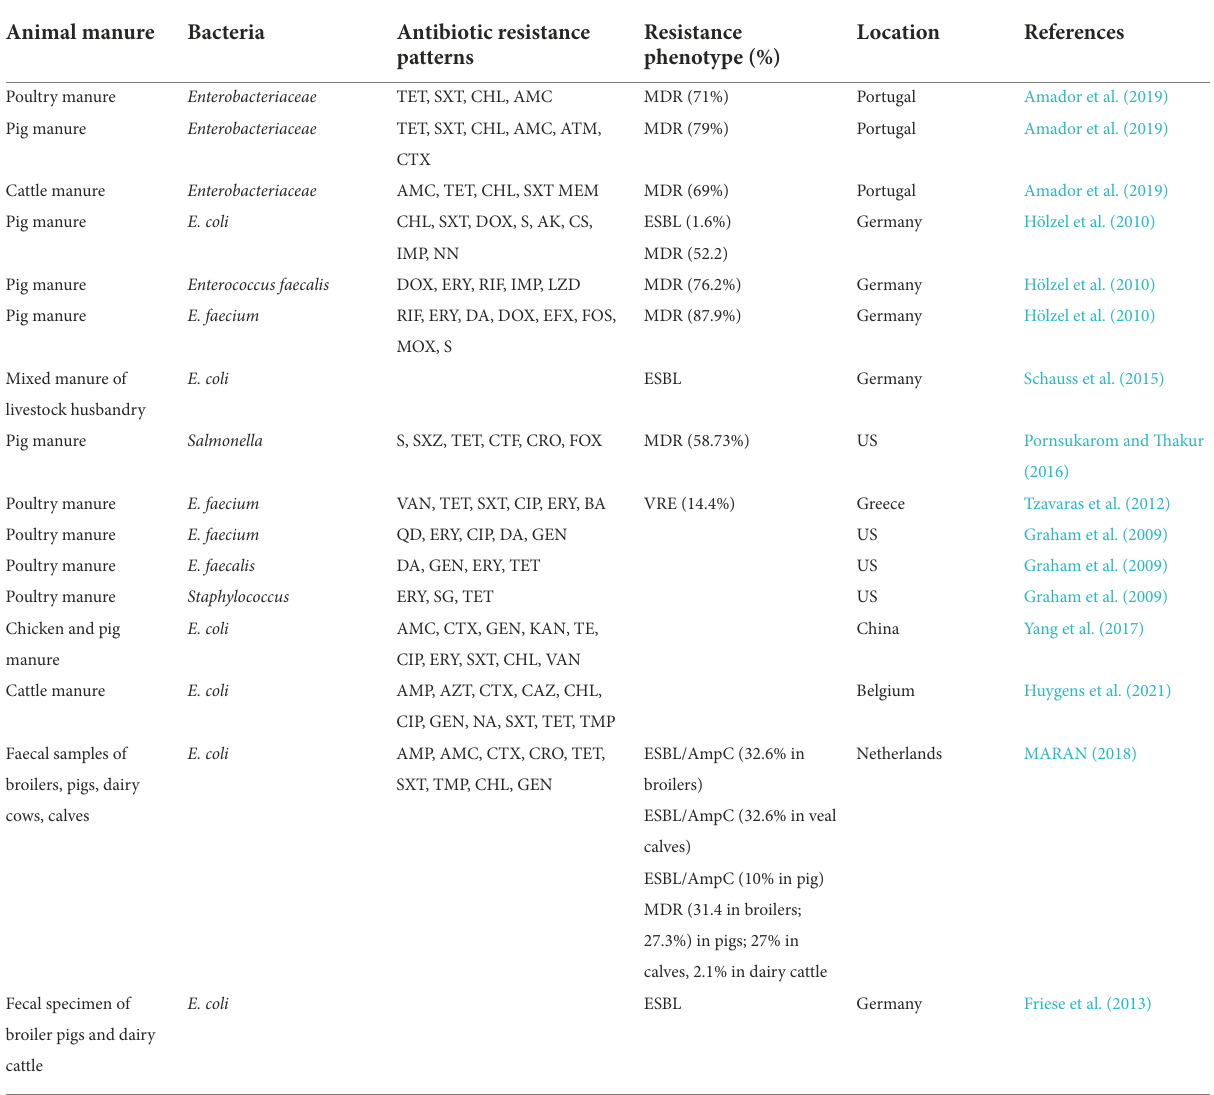
TABLE 2 ARB found in